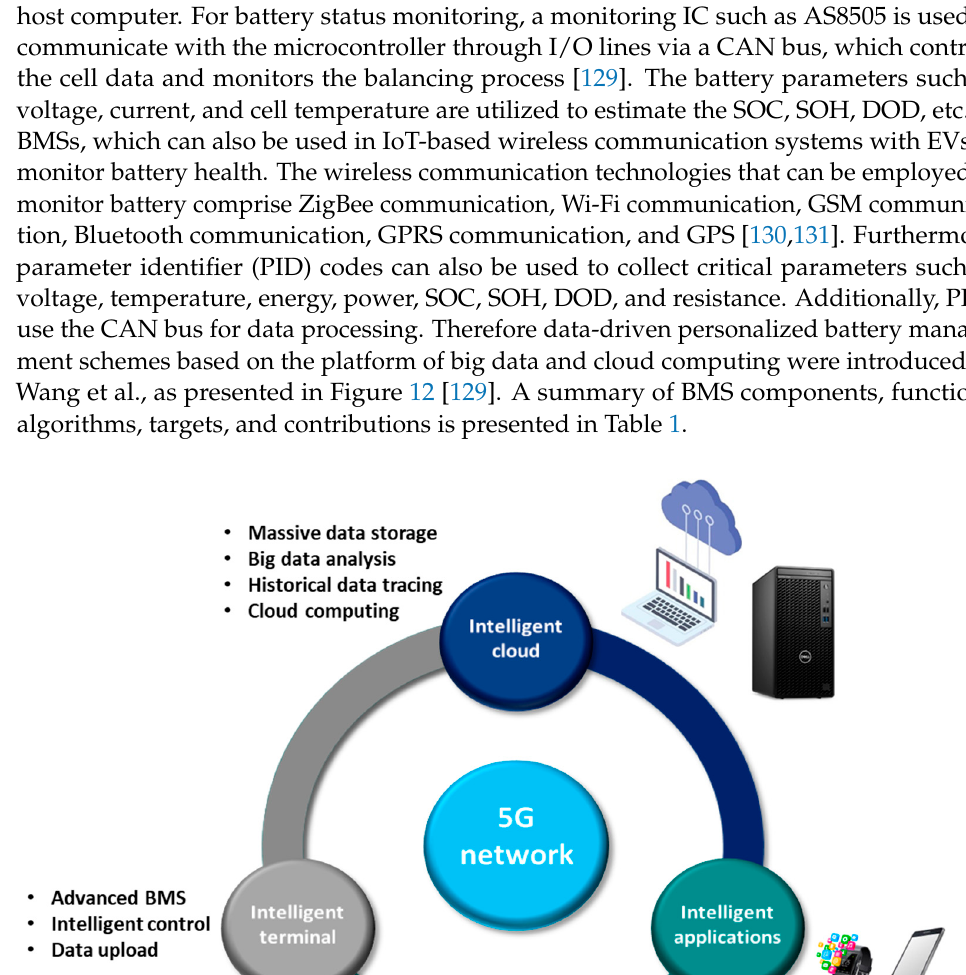
Figure 11. Fault diagnosis process of a battery system.